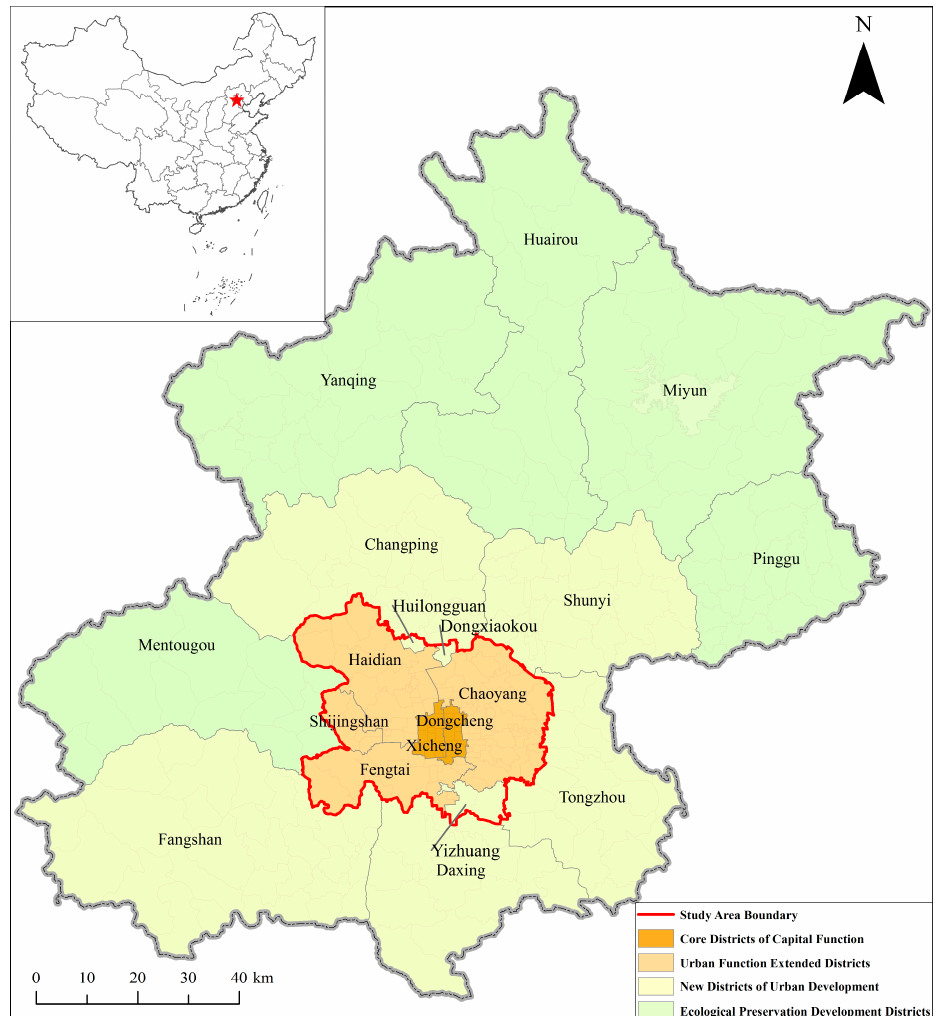
Figure 1. The study area consists of the urban area and three suburb districts with dense residential communities or industrial parks (Huilongguan, Dongxiaokou, and Yizhuang). communities or industrial parks (Huilongguan, Dongxiaokou, and